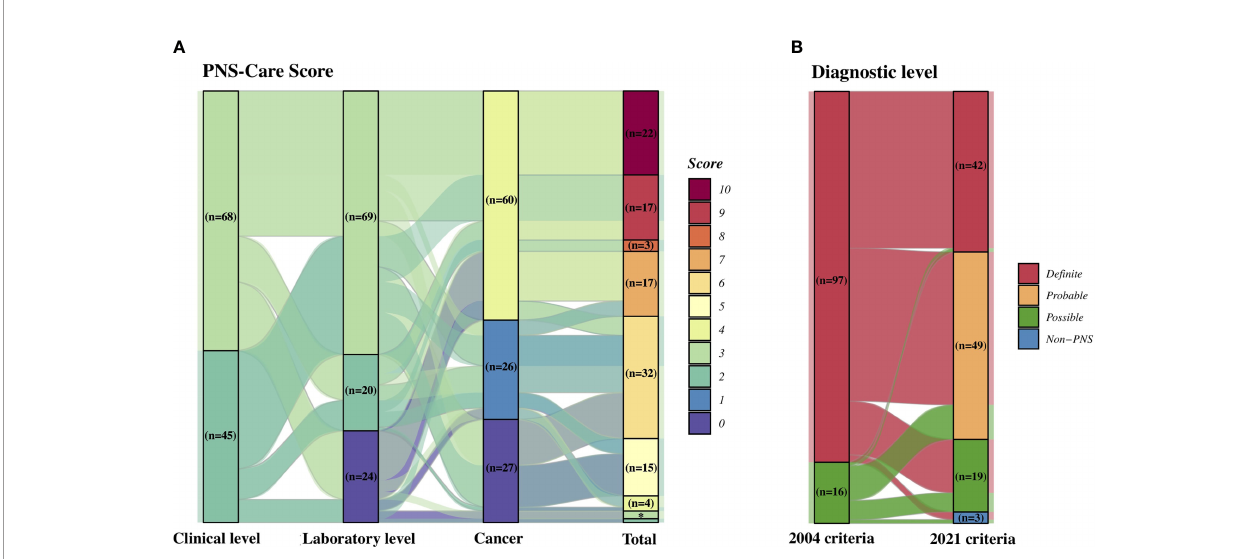
FIGURE 3 | Diagnostic performance of the 2 criteria. (A) Number of patients corresponding to PNS-Care score. (B) Comparison of diagnostic levels between the 2004 and 2021 PNS criteria. PNS, paraneoplastic neurologic syndrome. *There were 2 patients with a total score of 3 and 1 patient with a score of